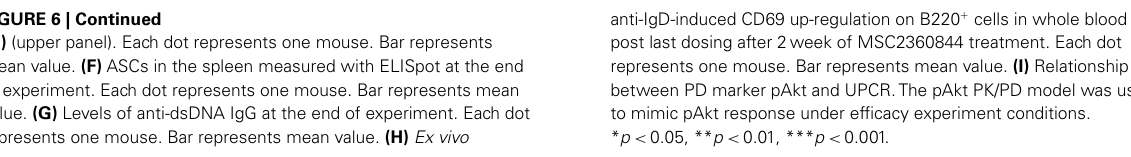
represents one mouse. Bar represents mean value. (I) Relationship between PD marker pAkt and UPCR.The pAkt PK/PD model was used